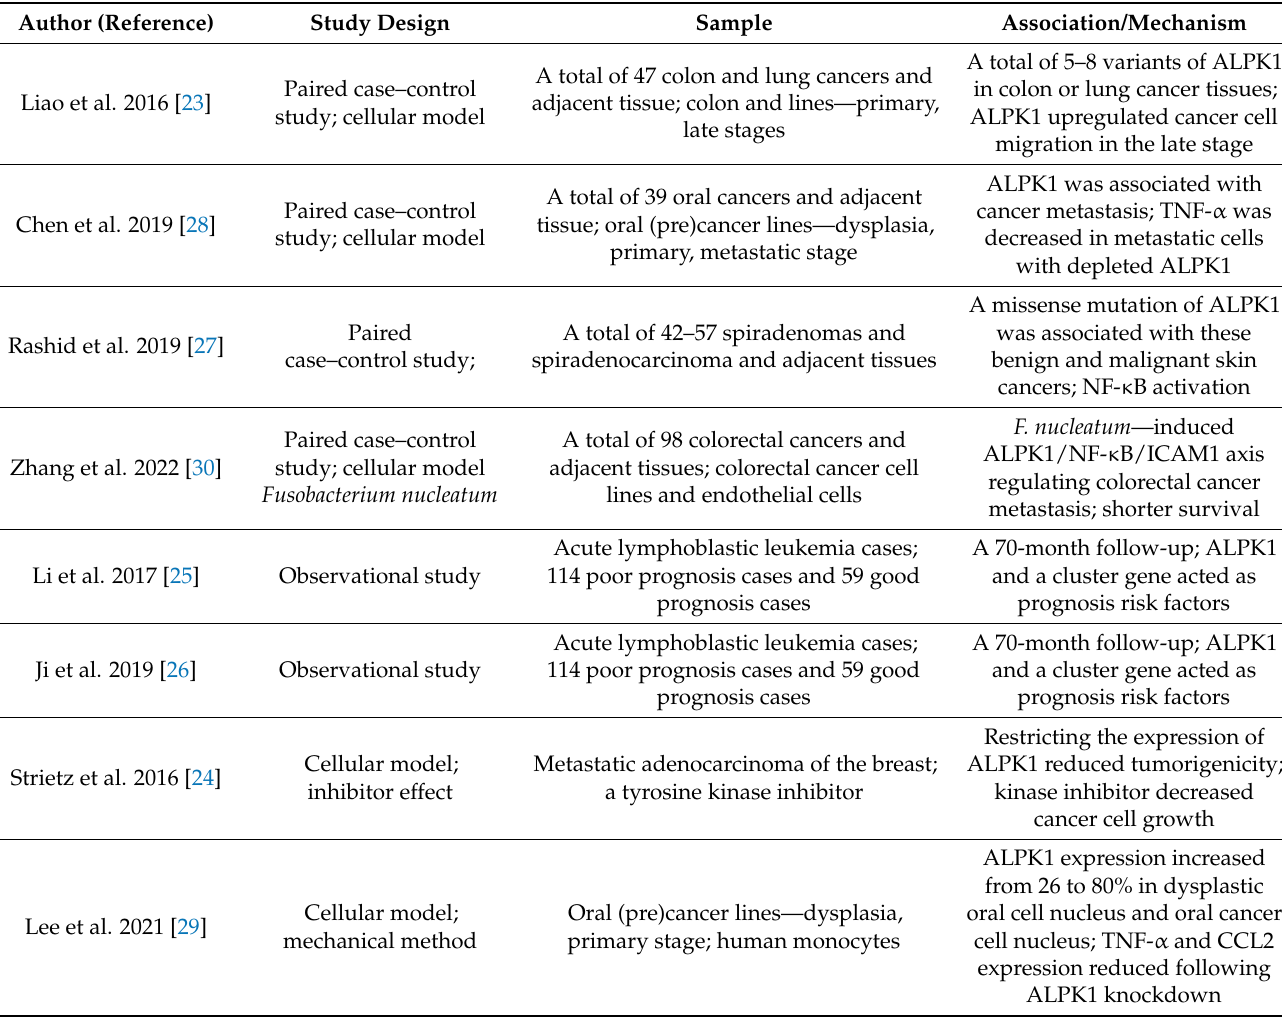
Table 1. Evidence of the association between ALPK1 and